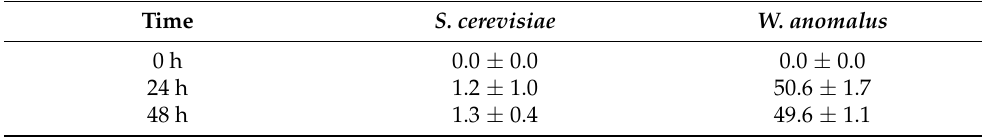
Table 1. Gliadin hydrolysis percentage in wheat flour fermentation with S. cerevisiae and W. anomalus